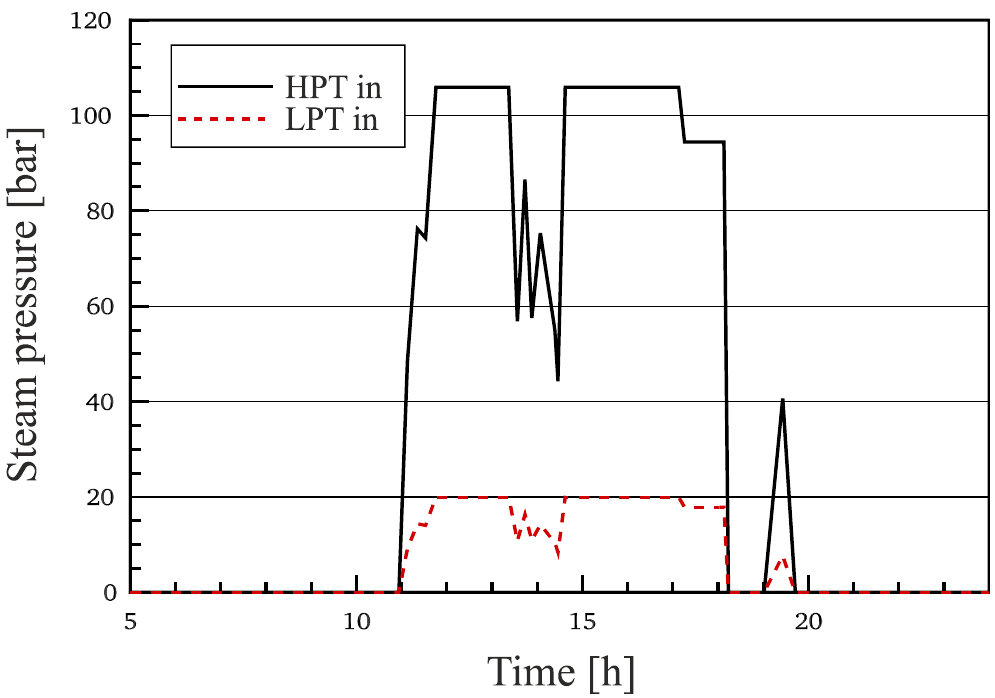
Figure 8. Simulated results of steam pressure at the inlet of the high- and low-pressure turbine.